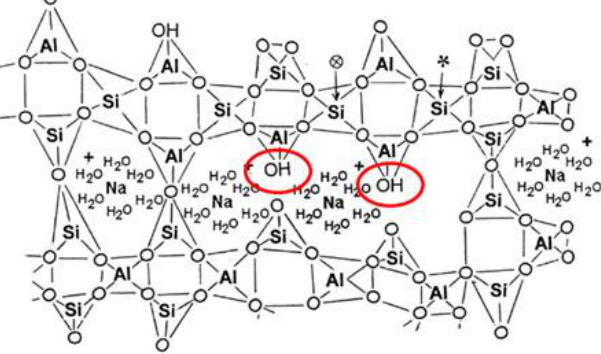
Figure 5. Schematic structure of sodium-aluminosilicate-hydrate (N-A-S-H) [48].